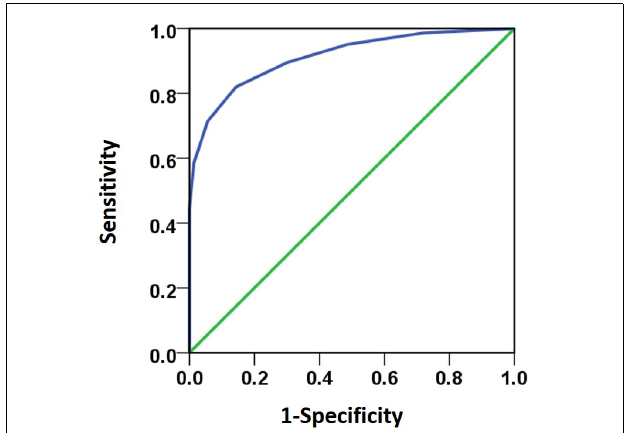
FIGURE 4 | The ROC curve analyses was used to analyze subjects’ response to various stereo thresholds. The AUC (0.91) was significant higher ( p = 0.0001) than the 0.5 level. The sensitivity and specificity at the optimal critical point were 0.82 and 9.86,